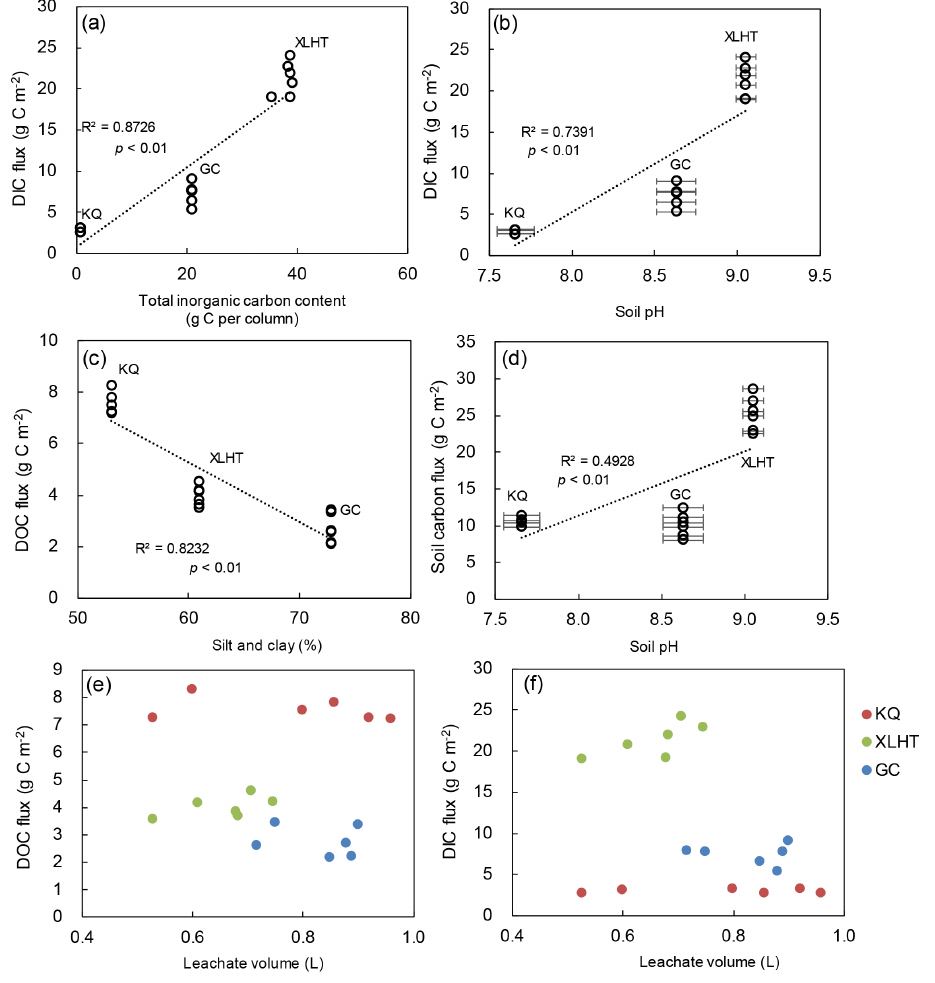
Figure 6. Relationship of dissolved inorganic carbon (DIC) and dissolved organic carbon (DOC) fluxes with soil properties: (a) DIC flux with total inorganic carbon in the soil columns; (b) DIC flux with soil pH; (c) DOC flux with silt and clay content of soils; (d) total soil carbon flux with soil pH; (e) DOC flux with leachate volume; (f) DIC flux with leachate volume. Mean pH values are shown with standard error ( n =